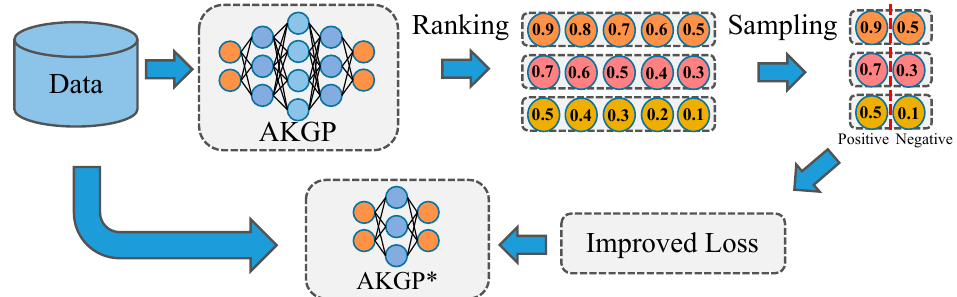
Figure 5. Structure diagram of stratified sampling method. The prediction samples obtained from AKGP are first grouped and arranged in descending order according to the preference of the samples. Then, samples with similar preference values are placed in the same group. The sum of the preference levels of samples in each group is the same. Then, the samples in each group are identified as positive or negative according to the sample labels. Finally, the scores are input into the adversarial training loss function, which is iterated into AKPG*